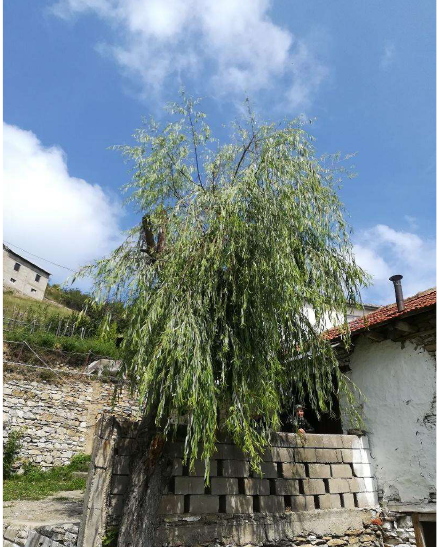
Figure 7. Salix alba in a courtyard in Sallarevë (Photo: A. Pieroni).